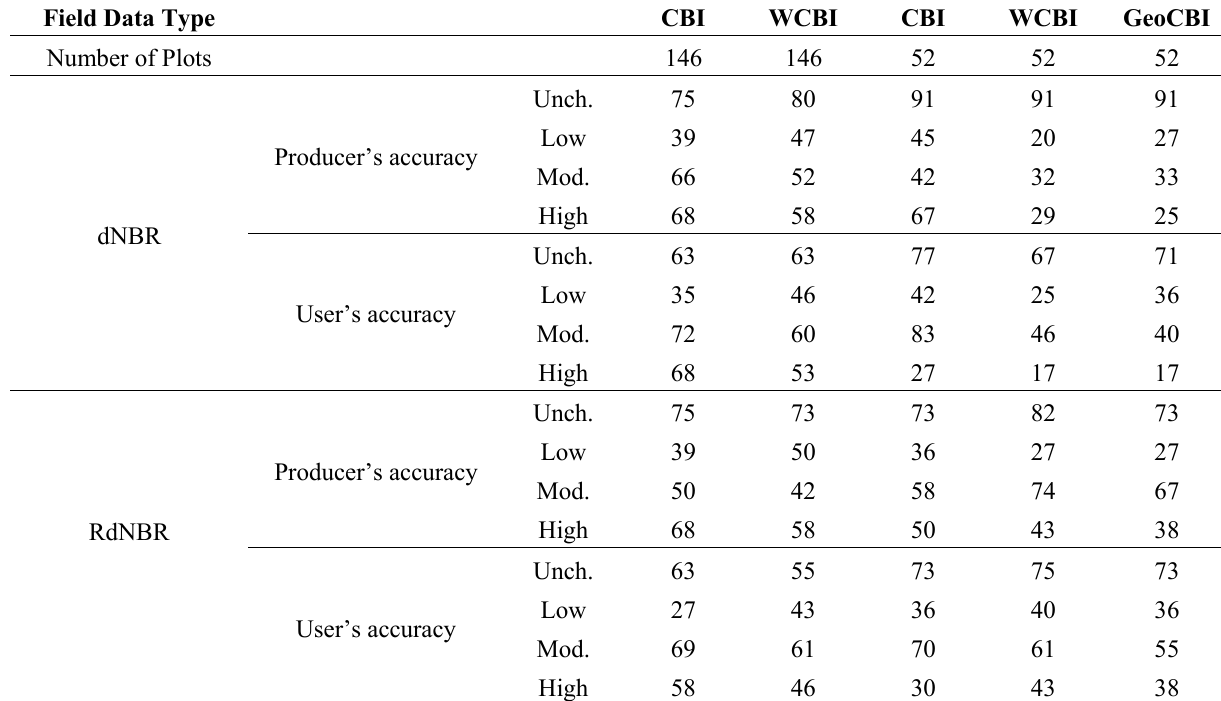
Table 8. User’s and producer’s accuracy for individual burn severity classes for dNBR and RdNBR. Field Data Type Number of Plots